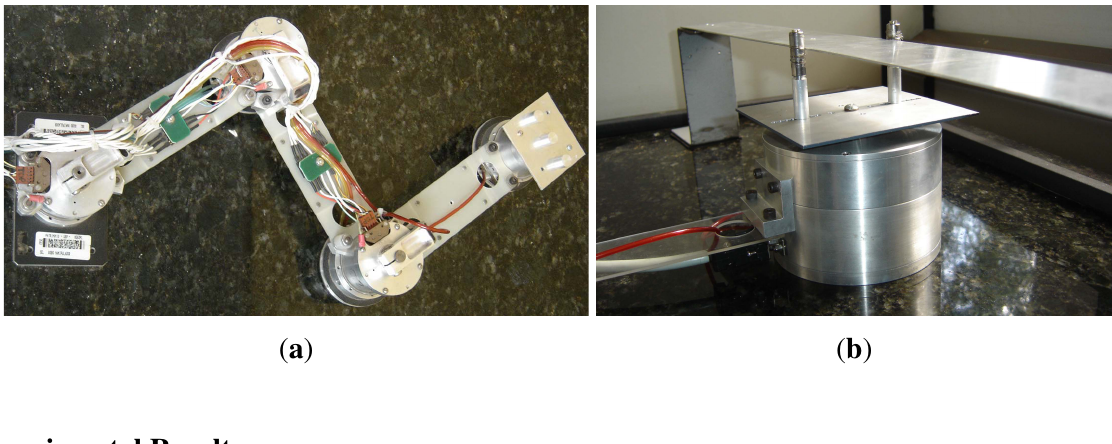
Figure 8. ( a ) UnderActuated Robot Manipulator; ( b ) Force sensor device coupled to the UARM